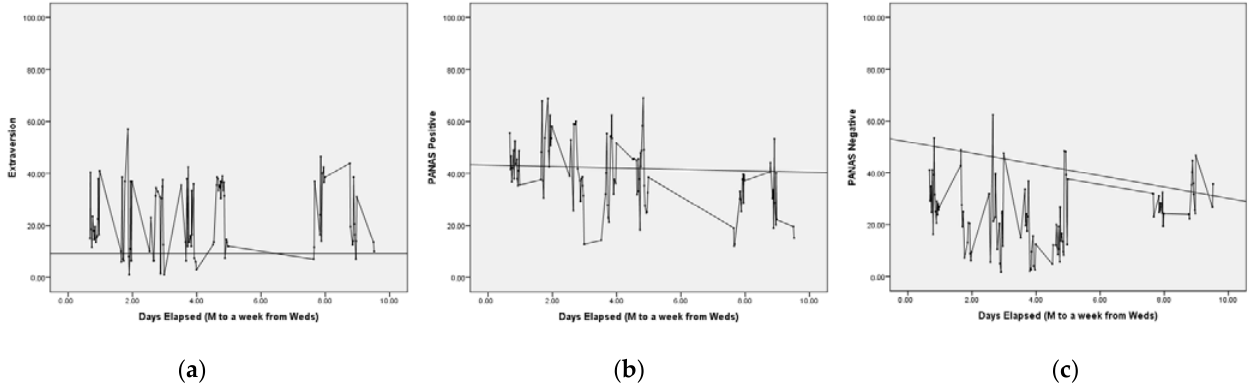
Figure 3. ( a – c ). Variability in Extraversion and Positive PANAS Affect, Alice. Notes: Straight line connects pre and post paper and pencil measurements. All PANAS and TIPI scales expressed on 1-to-100 scales.